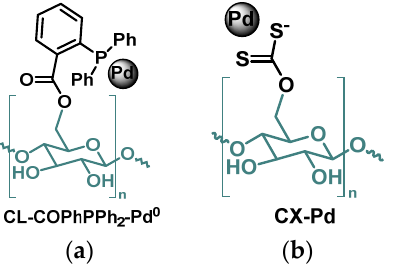
Figure 9. ( a ) Triphenylphosphine containing cellulose-supported Pd NPs [43]; ( b ) cellulose xanthate-supported Pd NPs [81].